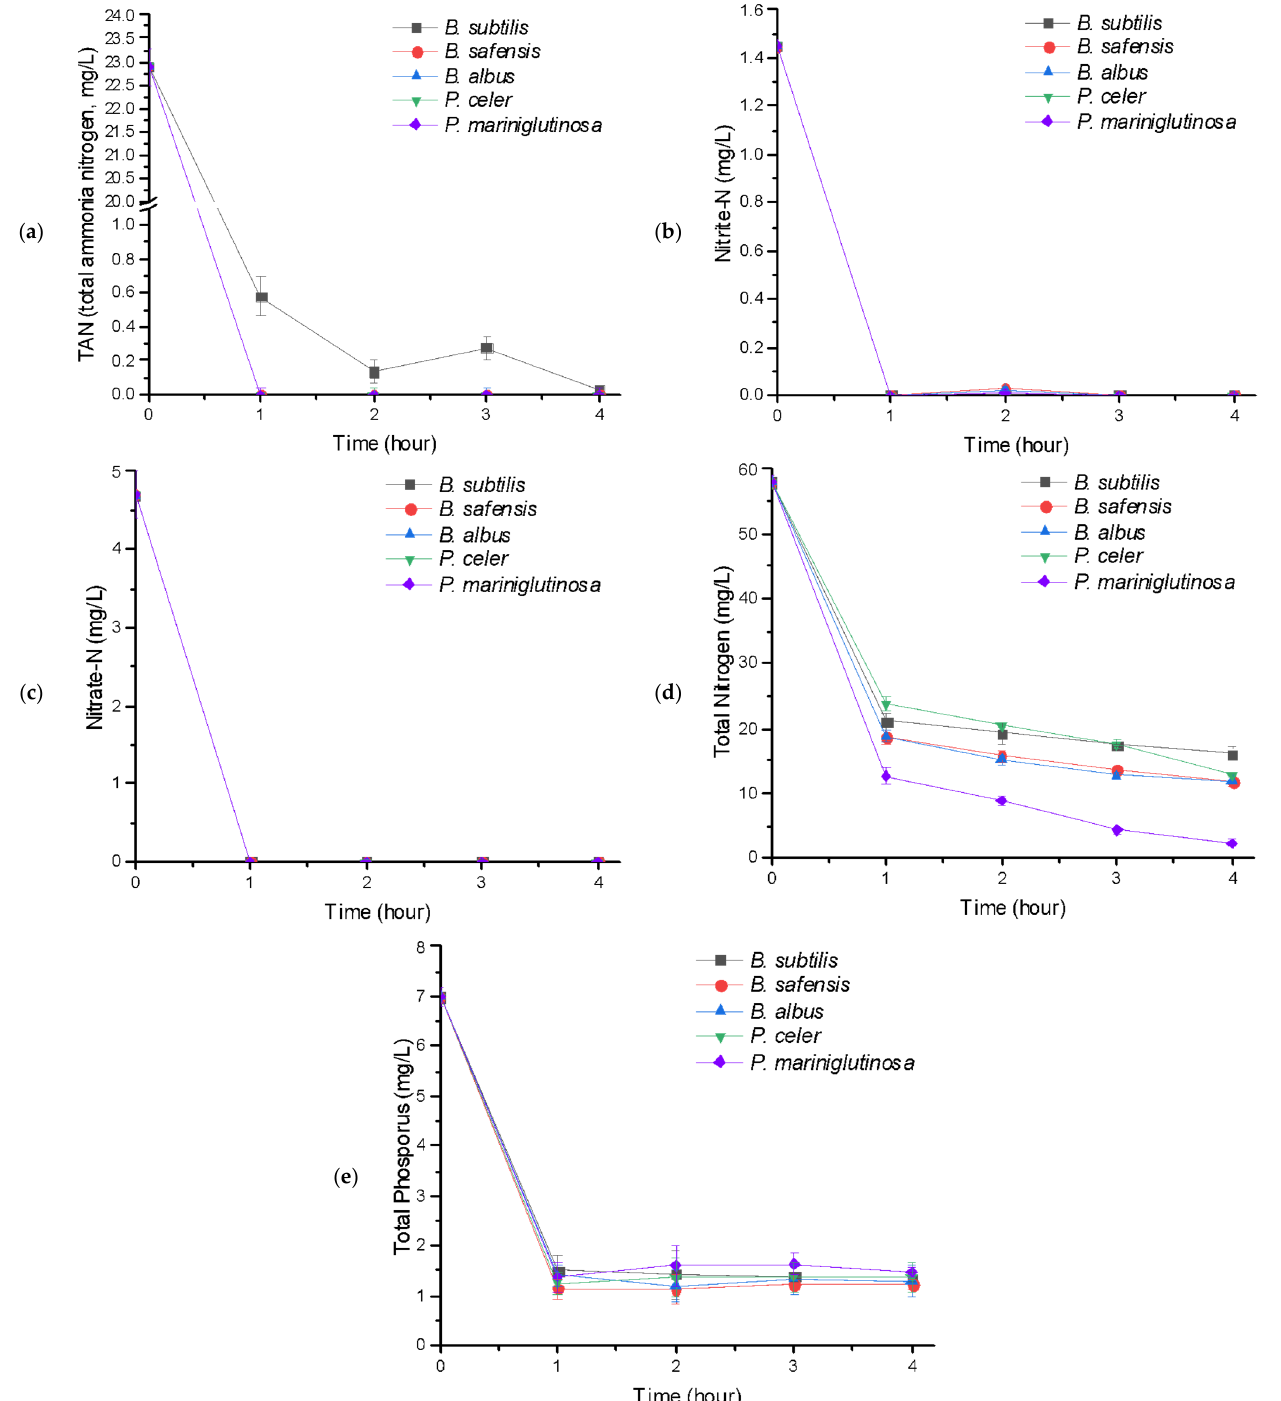
Figure 2. Nutrient-removal efficacy: ( a ) TAN (total ammonia nitrogen), ( b ) Nitrite-N (NO 2 -N), ( c ) Nitrate-N (NO 3 − -N), ( d ) Total nitrogen (TN), and ( e ) Total phosphorus (TP). Groups: Bacillus subtilis , Bacillus safensis , Bacillus albus , Psychrobacter celer , and Pseudoalteromonas mariniglutinosa .